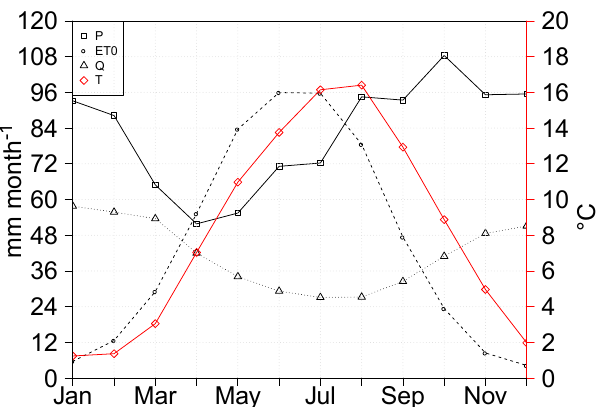
Figure 3. Climatology of the Ahlergaarde catchment. Values for precipitation ( P ), reference evapotranspiration ( E T 0 ), streamflow ( Q ) and temperature ( T ) are monthly average values over the period